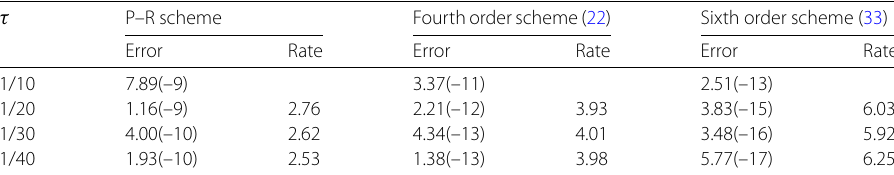
Table 2 L 2 -error and convergence rate for Problem 1 with h = 0.02 at T = 1